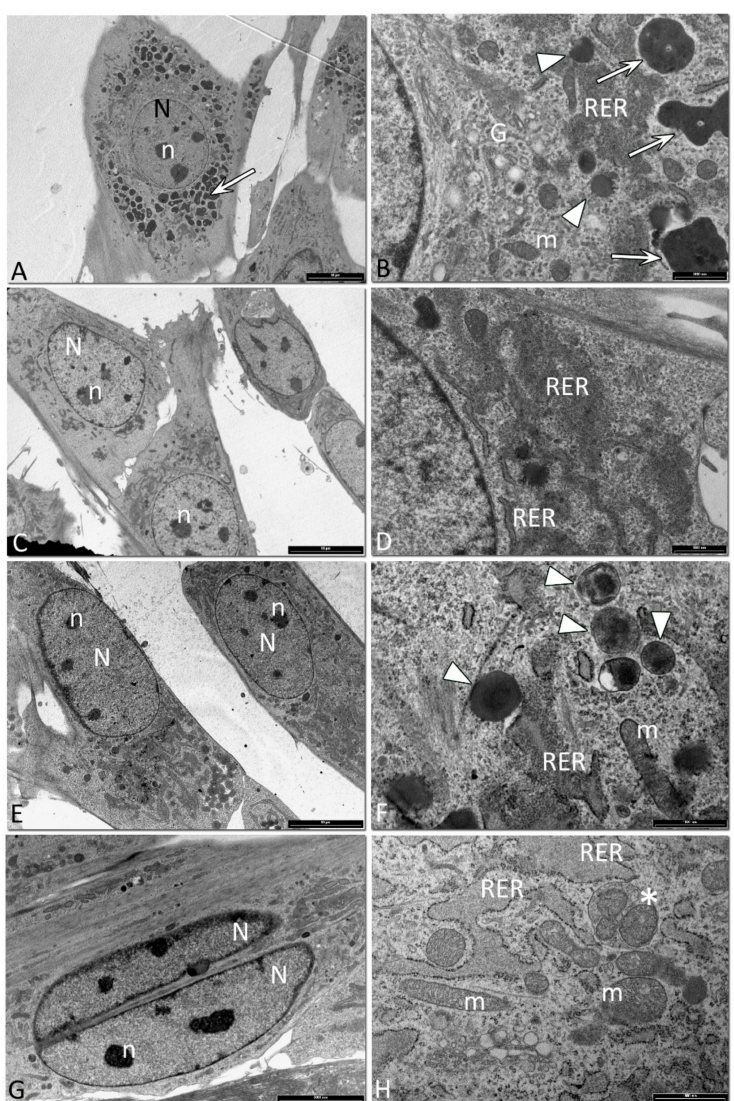
Figure 7. Representative images of the SfMSC ultrastructure. ( A ) Equine SfMSCs from a 3-year-old donor, showing a polygonal shape, with a round nucleus (N) and several nucleoli (n). The cytoplasm is characterized by the presence of several secondary lysosomes (white arrow) (bar: 10 µ m). ( B ) Higher magnification of equine SfMSCs from a 3-year-old donor. A Golgi complex (G), mitochondria (m) and an enlarged rough endoplasmic reticulum (RER) are detected in the cytoplasm. Primary (arrowhead) and secondary lysosomes (white arrow) are observed (bar: 100 nm). ( C ) Equine SfMSCs from a 12-year-old donor. Cells showed a well-preserved nucleus (N) and nucleoli (n) and a widely developed RER, surrounding the nuclear envelope. There is a clear lack of secondary lysosomes (bar: 10 µ m). ( D ) Cytoplasm details of equine SfMSCs from a 12-year-old donor, in which a regular RER and enlarged RER are clearly observed (bar: 1 µ m). ( E ) Equine SfMSCs from a 23-year-old equine donor showing a fibroblast-like shape, regular nucleus (N), and several nucleoli (n) (bar: 10 µ m). ( F ) Higher magnification of the cytoplasm of equine SfMSCs from a 23-year-old donor. Several primary lysosomes (arrowheads), mitochondria (m), and dilated RER are observed (bar: 1 µ m). ( G ) Binucleated SfMSCs, corresponding to tetraploid cells, isolated from a 40-year-old equine donor showing a fibroblast-like shape, nucleus (N), and several nucleoli (n) (bar: 5000 nm). ( H ) Detail of the cytoplasm in which several mitochondria (m), a dilated RER, and mitophagy vesicles (*) are visible (bar: 1 µ